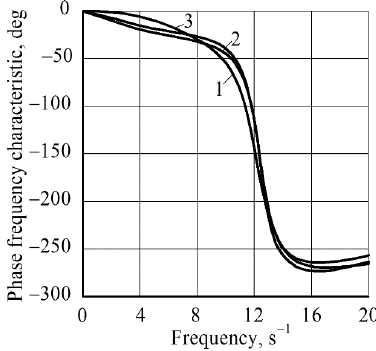
Figure 6. The phase–frequency characteristic of angle β during the processing of the disturbing impact by the technological module at different speeds of movement of the machine-and-tractor aggregate of a modular type ( V o ): 1—1 m ∙ s − 1 ; 2—2 m ∙ s − 1 ; 3—3 m ∙ s − 1 .